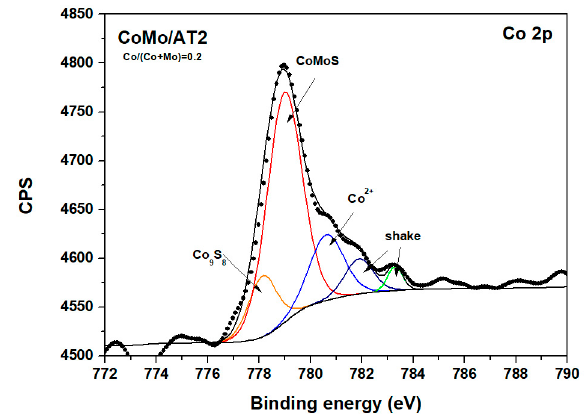
Figure 14. XPS deconvolution of Co 2p core level for sulfided 15 wt.% Mo CoMo / AT2 catalysts at the Co / (Co + Mo) = 0.2 ratio.